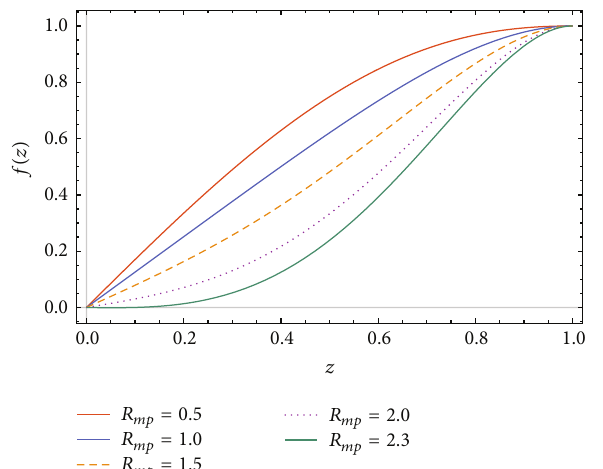
Figure8: Velocity profilefordifferentvalues of 𝑚 𝑝 with 𝑚 ℎ = 𝑅 𝑚ℎ = 1 .